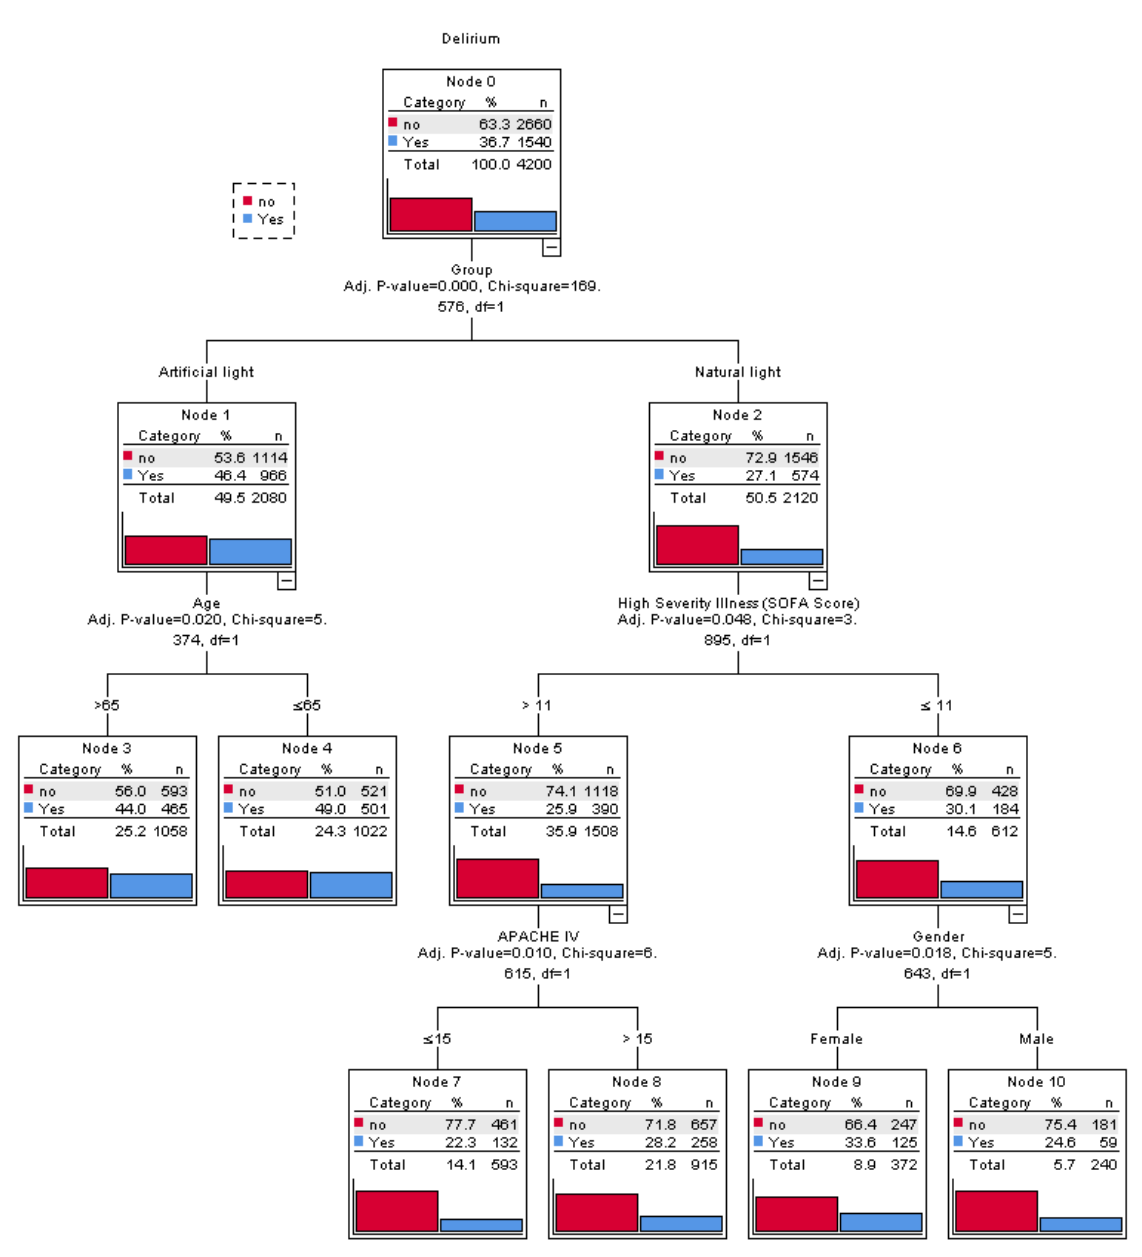
Figure 2: A CHAID decision classification tree analysis to predict delirium among participants